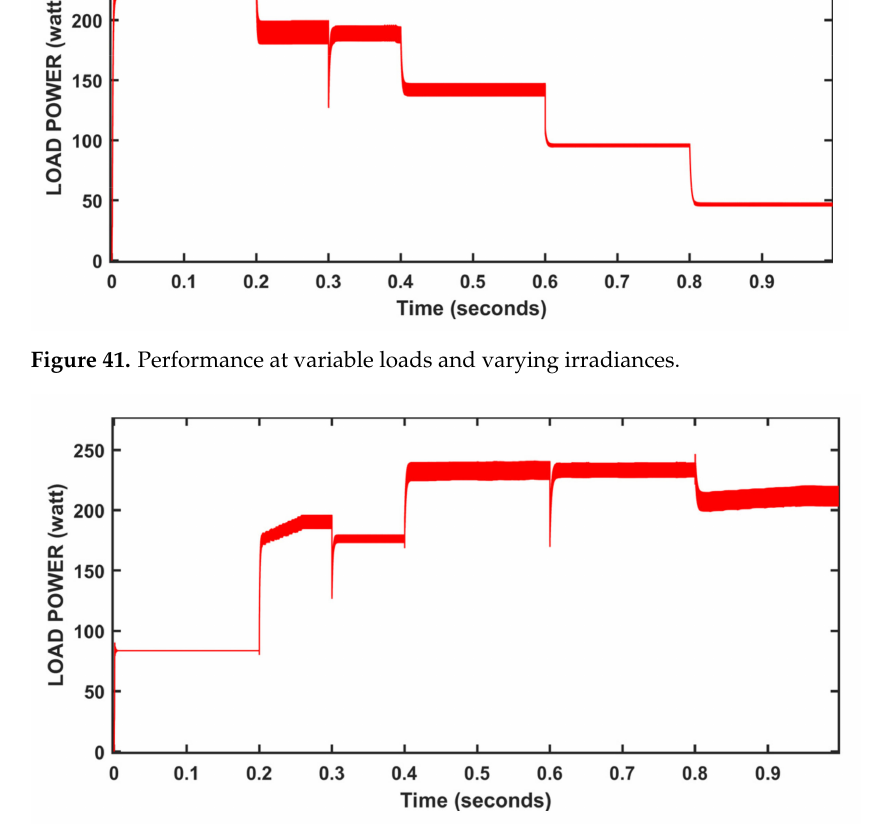
Figure 42. Performance at variable temperatures and variable loads.